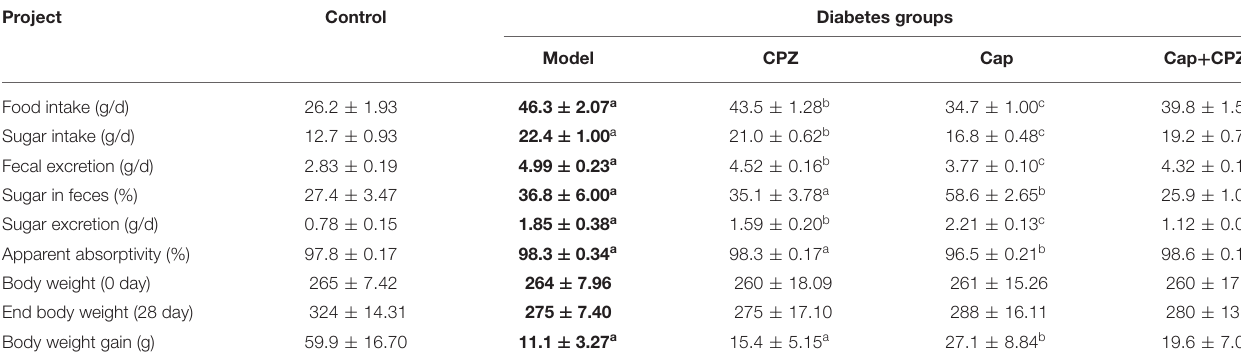
TABLE 1 | Effects of TRPV1 receptor antagonist and capsaicin on weight and apparent absorption of TS in STZ-induced diabetic rats.